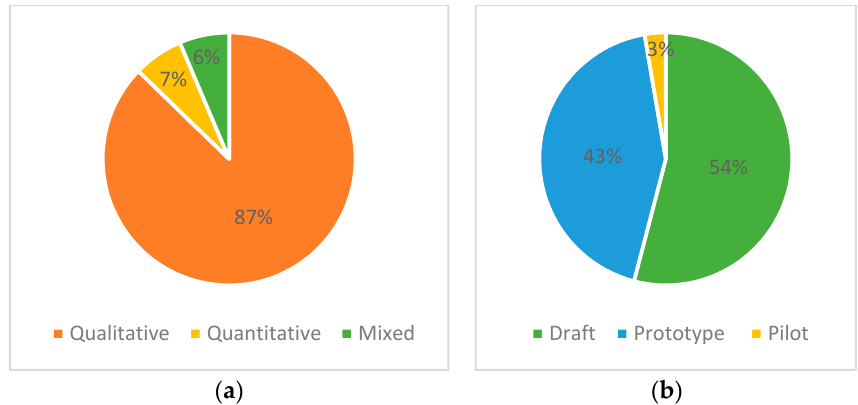
Figure 6. Methodology and stage of research. ( a , b ) display the methodology types and prototype stages.